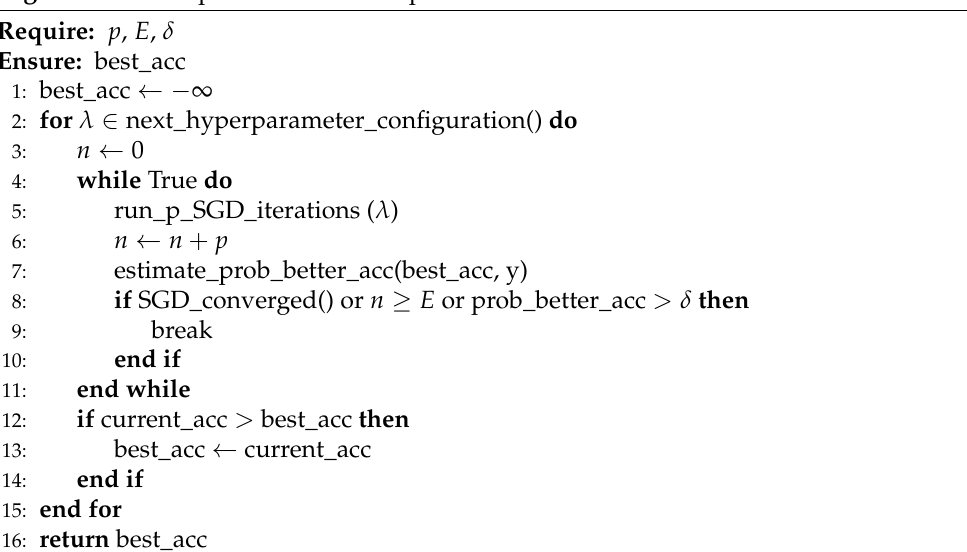
Algorithm 2 Extrapolation Method